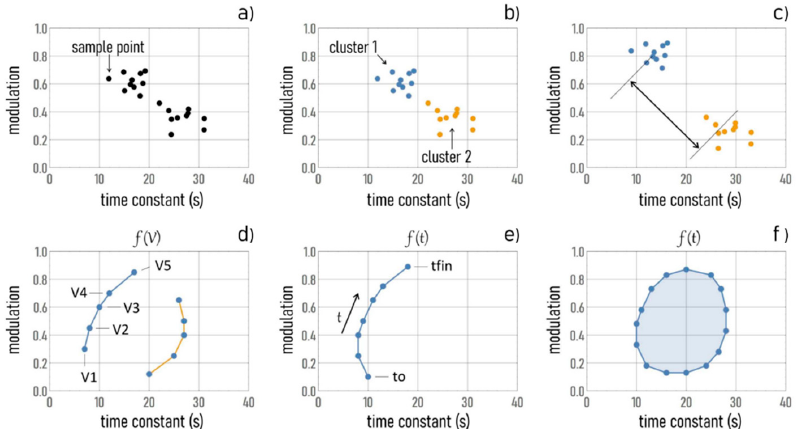
Figure 5. The response of the SeOECT devices is described by the sole variables modulation and time constant ( a ). The scatter plot of modulation against time constant may be indicative of differences between samples and can be used to operate sample separation, clustering, and classification ( b ). Separation between species can be improved by setting high voltage values and using sensors positioned at the border of the drop, where Marangoni flows are maximized ( c ). The modulation and time constant variables can be parametrized by voltage ( d ) and by time ( e ). The form of these trajectories can be indicative of the time evolution of the system ( f ).